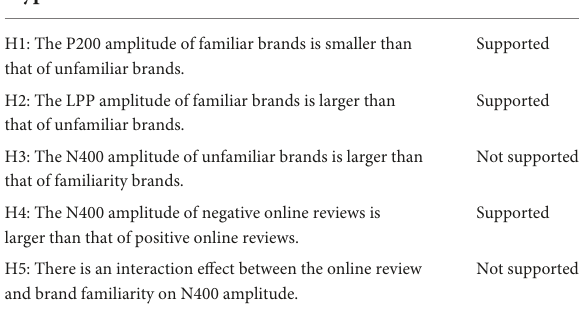
TABLE 3 Hypothesis testing